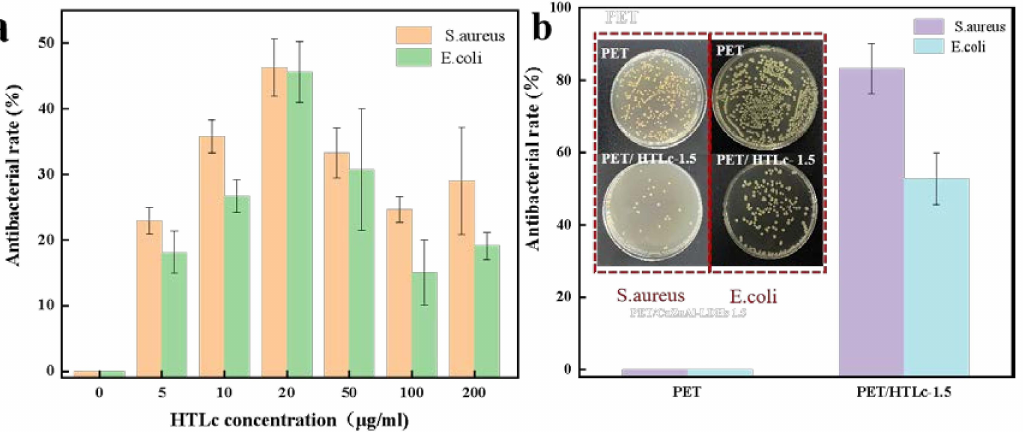
Figure 5. Antibacterial performance of HTLc and PET/HTLc-1.5: ( a ) Antibacterial rates of HTLc against S. aureus and E. coli at different concentrations. ( b ) Antibacterial rates of PET/HTLc-1.5 film against S. aureus and E. coli